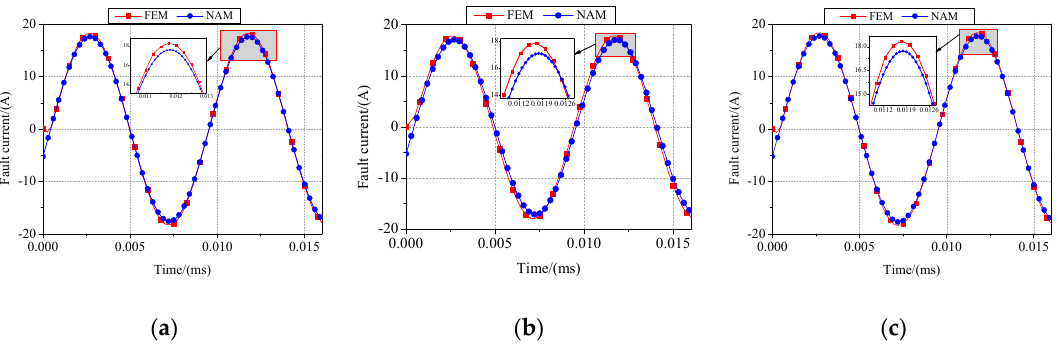
, the fault current i are analyzed the FEM and NA M, when there are 1 0 f turns shorted in the different layers of the faulty coil. Figure 1 8 a–c indicates that the frequency waveform obtained by the NA M is coincided properly with the ones obtained by the FEM with